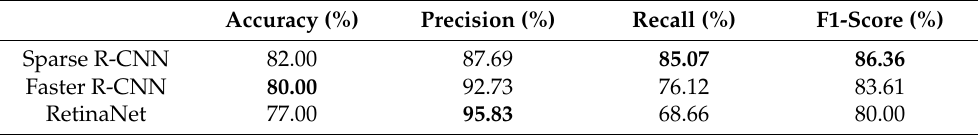
Table 13. Comparison of conflict indicator results based on three vehicle detection